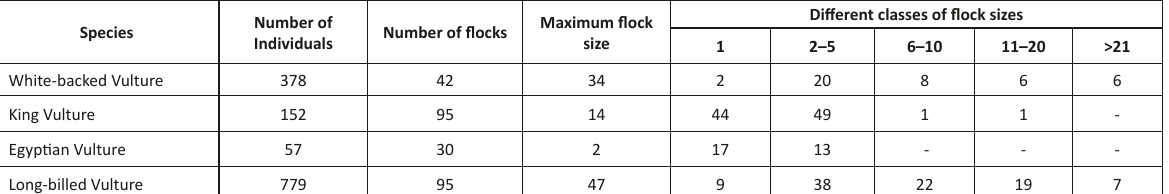
Table 1. Number of individuals, number of flocks and maximum flock size recorded for the four species of vultures in Bandhavgarh National Park